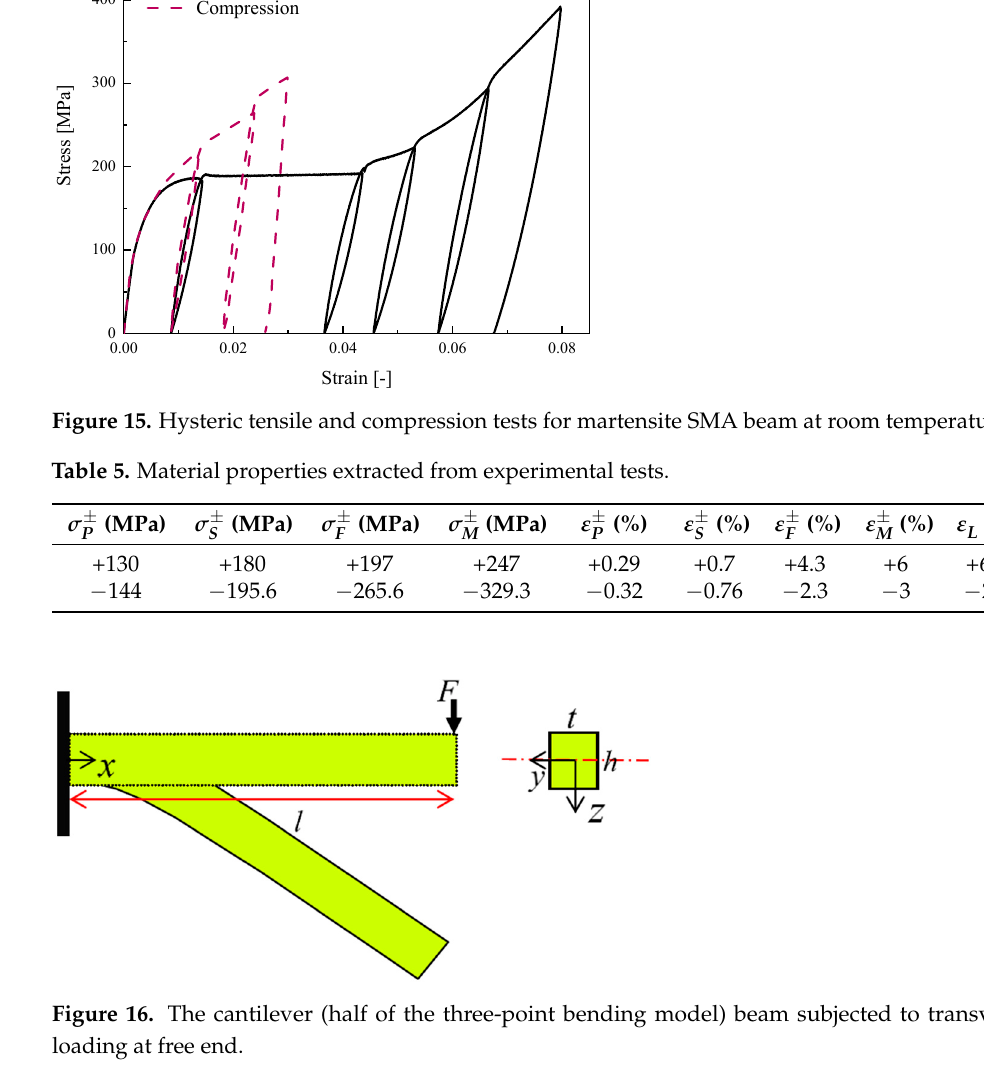
Figure 16. The cantilever (half of the three-point bending model) beam subjected to transverse load- ing at free end.